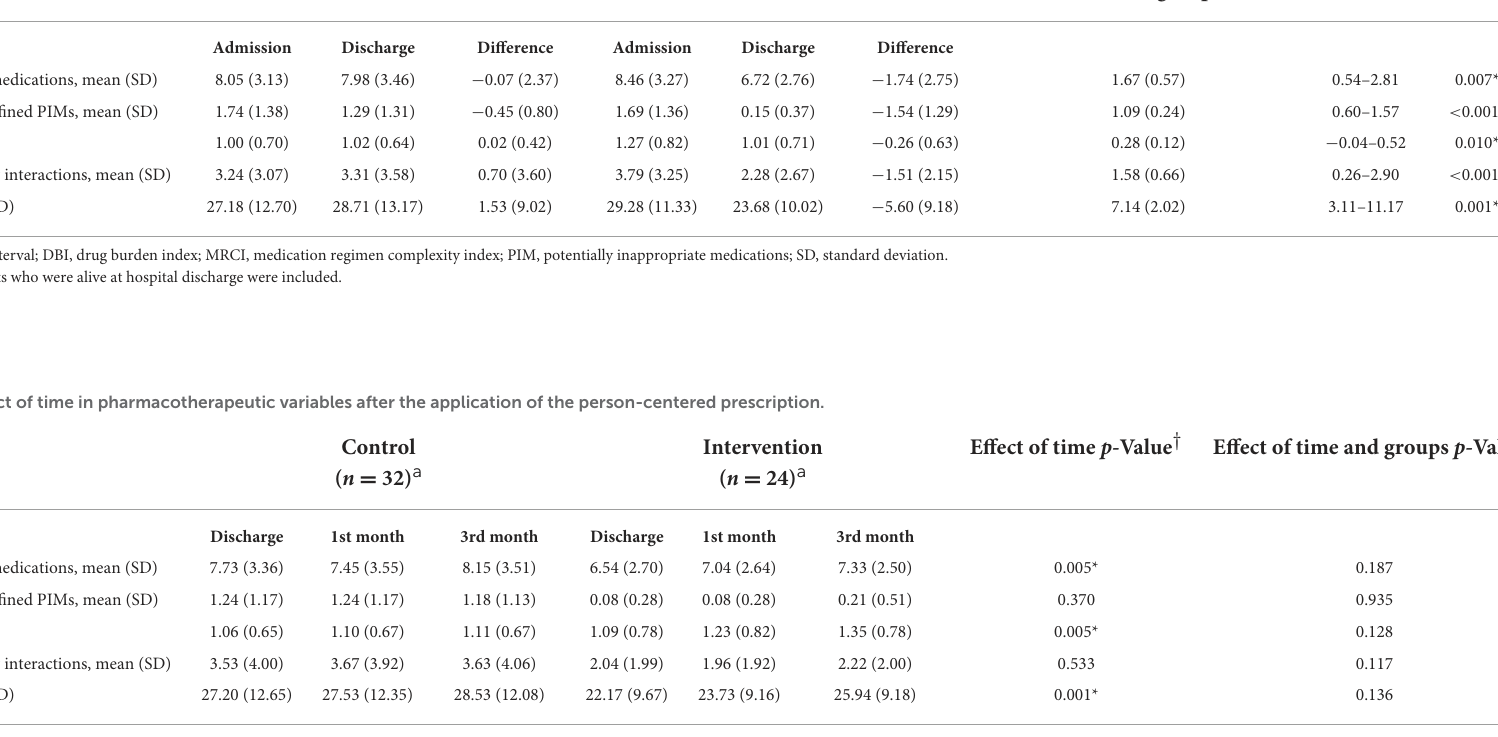
TABLE 2 Effectiveness in the pharmacotherapeutics variables after the application of the person-centered prescription model. Variable